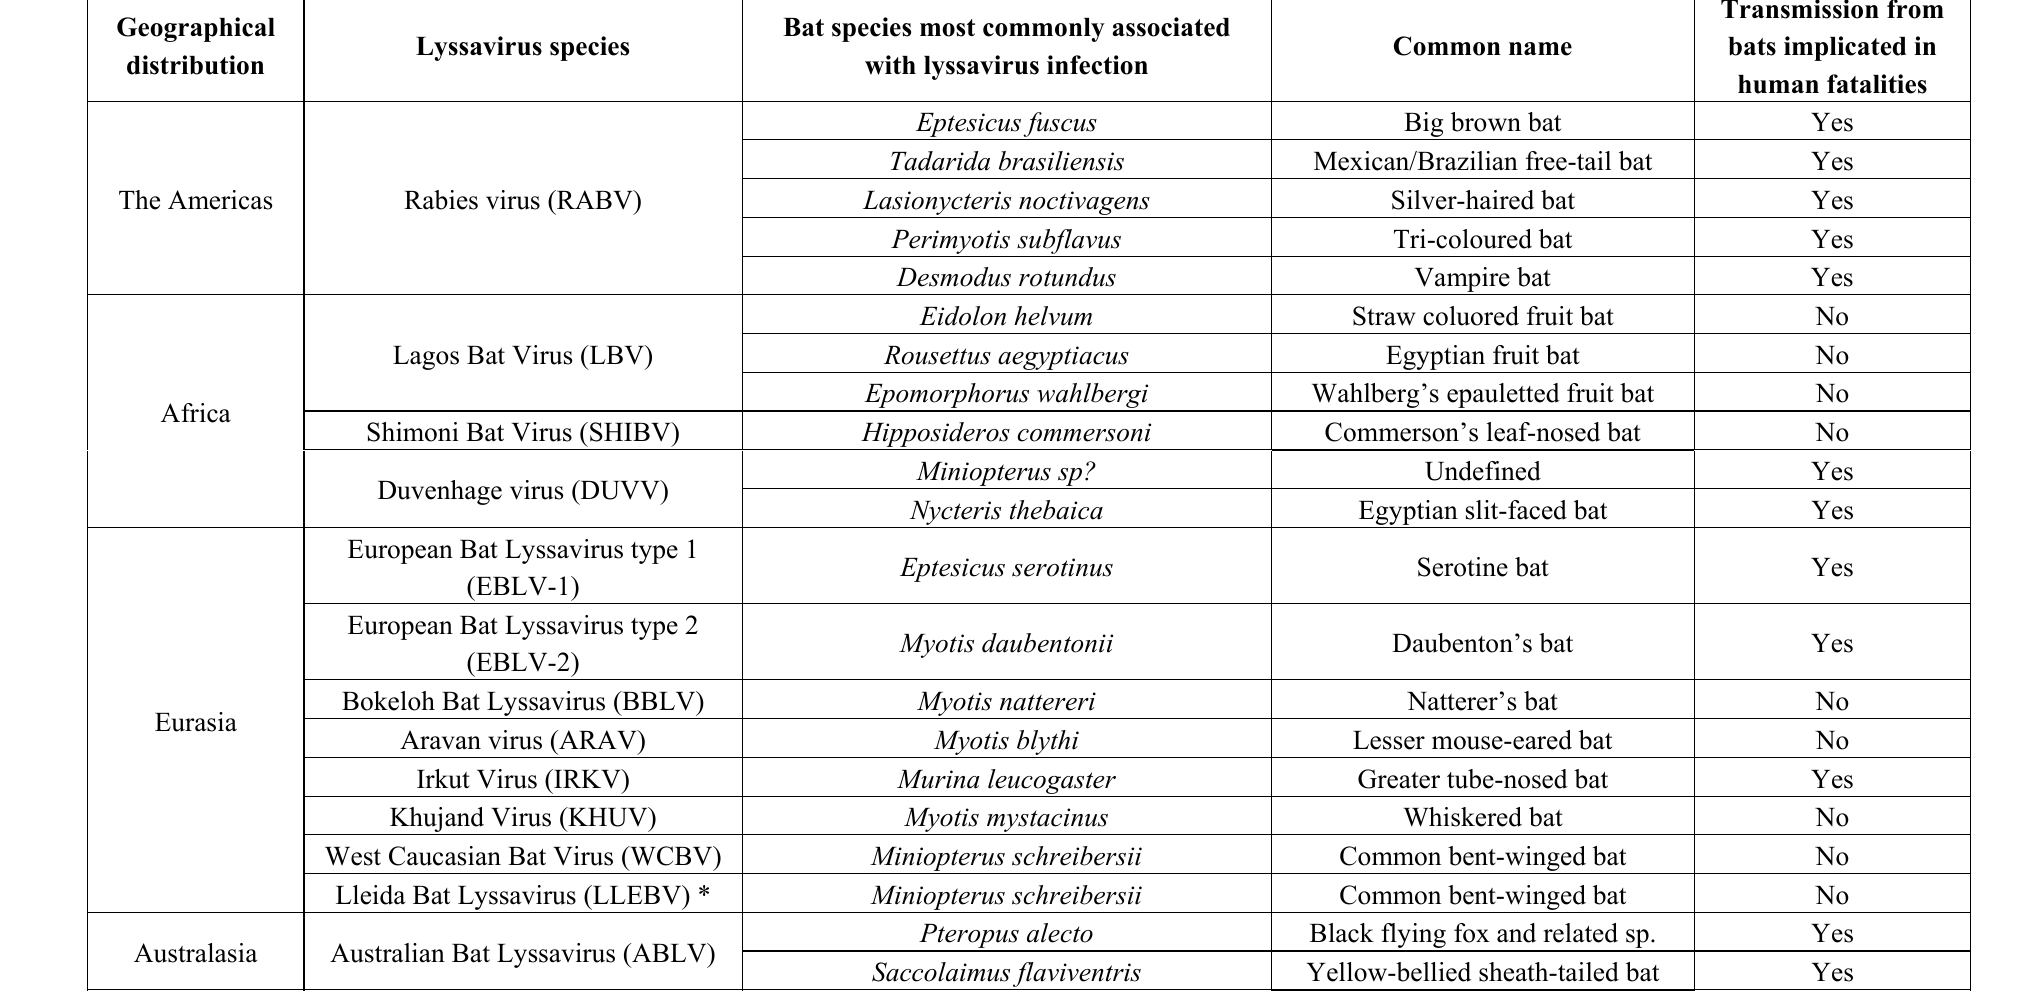
Table 1. Association of lyssaviruses with different bat species. * only genetic data has been reported for